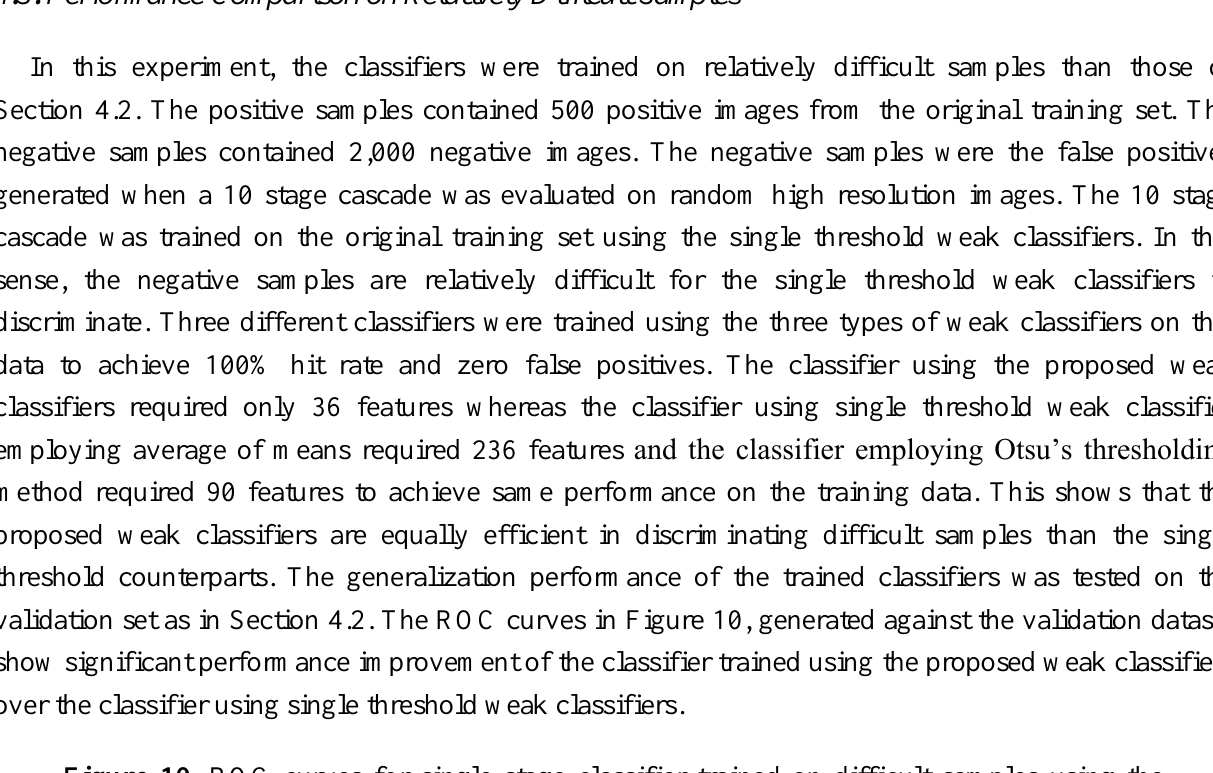
Figure 10. ROC curves for single stage classifier trained on difficult samples using the proposed weak classifiers and the single threshold weak classifiers. Single stage classifiers were trained on the negative samples acquired as false positives of an already trained 10 stage cascade using the single threshold based weak